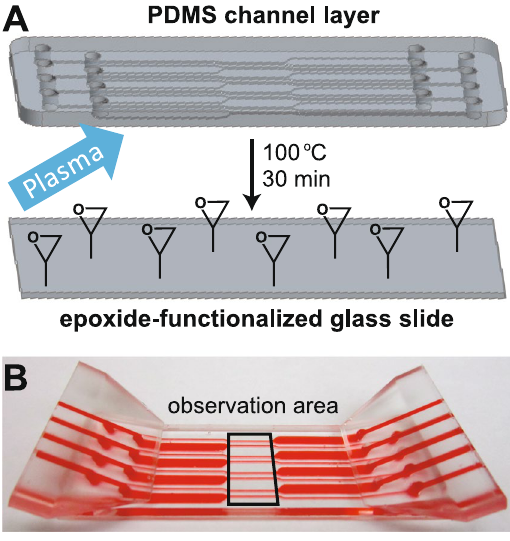
Figure 2. Microfluidic assembly. ( A ) Schematic showing the plasma-assisted thermal bonding of PDMS to an untreated epoxide-coated glass slide. ( B ) Photograph of the assembled microfluidic device. The black rectangle encloses the microscopic observation